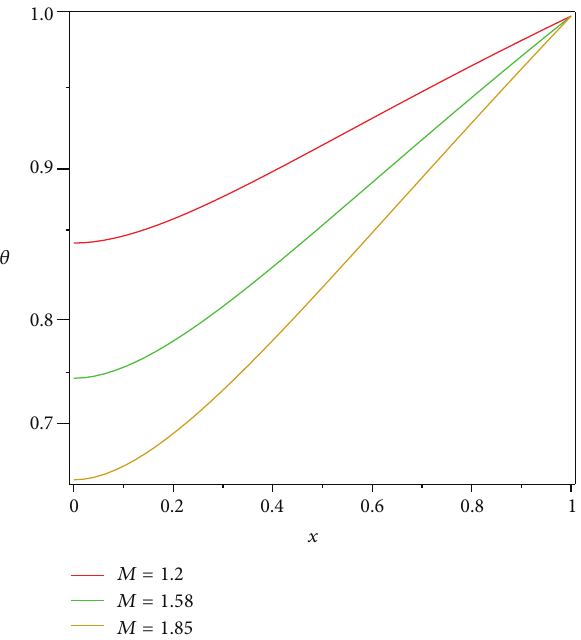
Figure 5: Temperature distribution of a fin profile 𝑓(𝑥) = (𝑥 + 1) 3 as given in solution (22) in a fin with varying values of the thermogeometric fin parameter. Here, 𝑛 is fixed at −1/4